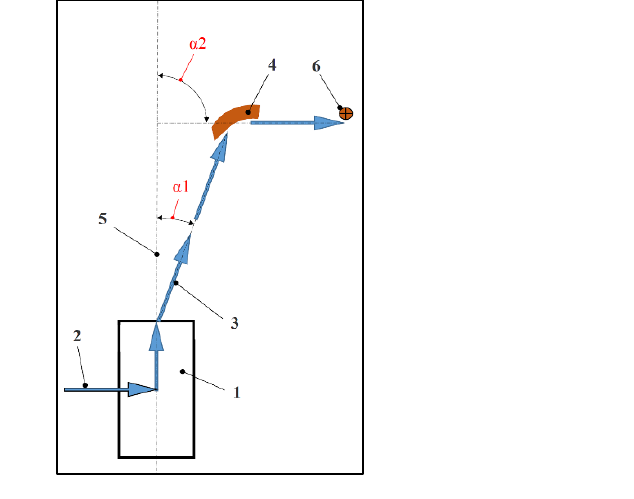
Figure 19. Switchgear diagram – variant No. 2: 1- switchgear; 2- inlet channel; 3- gas jet; 4- deflector; 5- axial line; 6-rotation center .